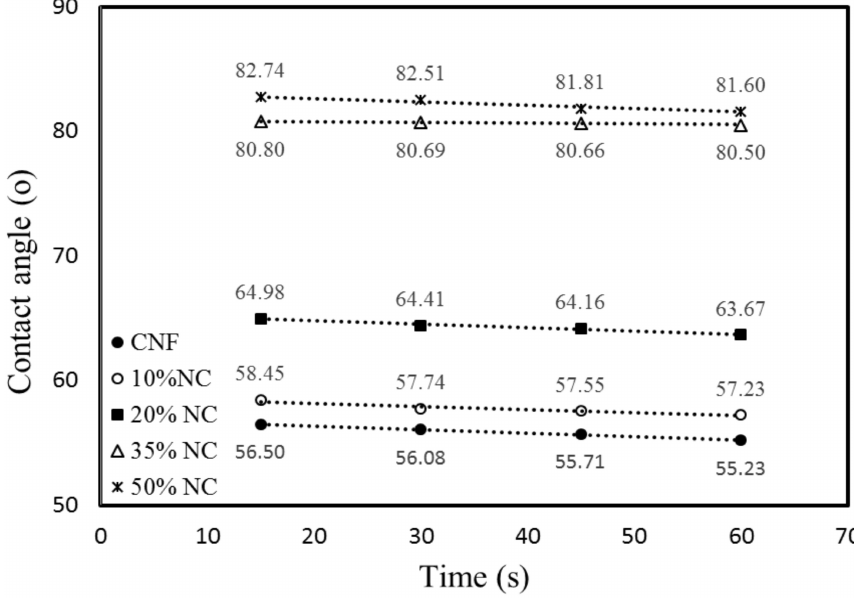
Figure 7. Evolution of the water contact angle of CNF-NC films containing di ff erent amounts of NC as a function of